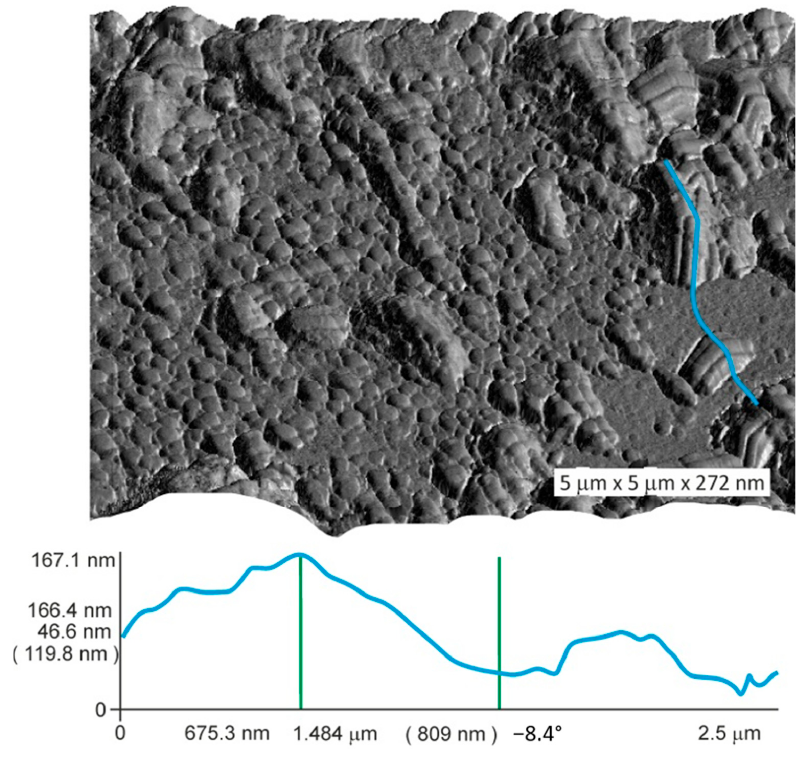
Figure 9. Atomic force microscopic image of magnetite crystal surface. The crystal from Experiment 5 (Table 1). Surface relief along the blue line shows the level difference of ~120 nm.